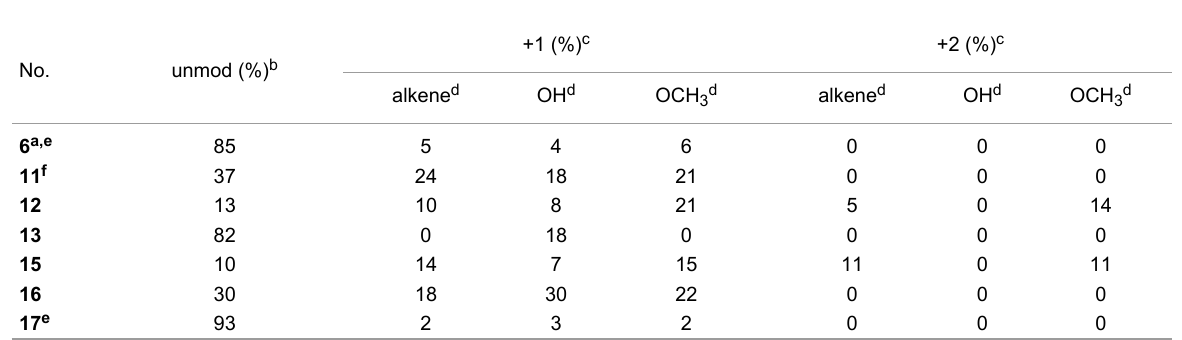
Table 1: Summary of lysozyme modifications by onchidal ( 6 ) and analogues 11 – 13 and 15 – 17 . a